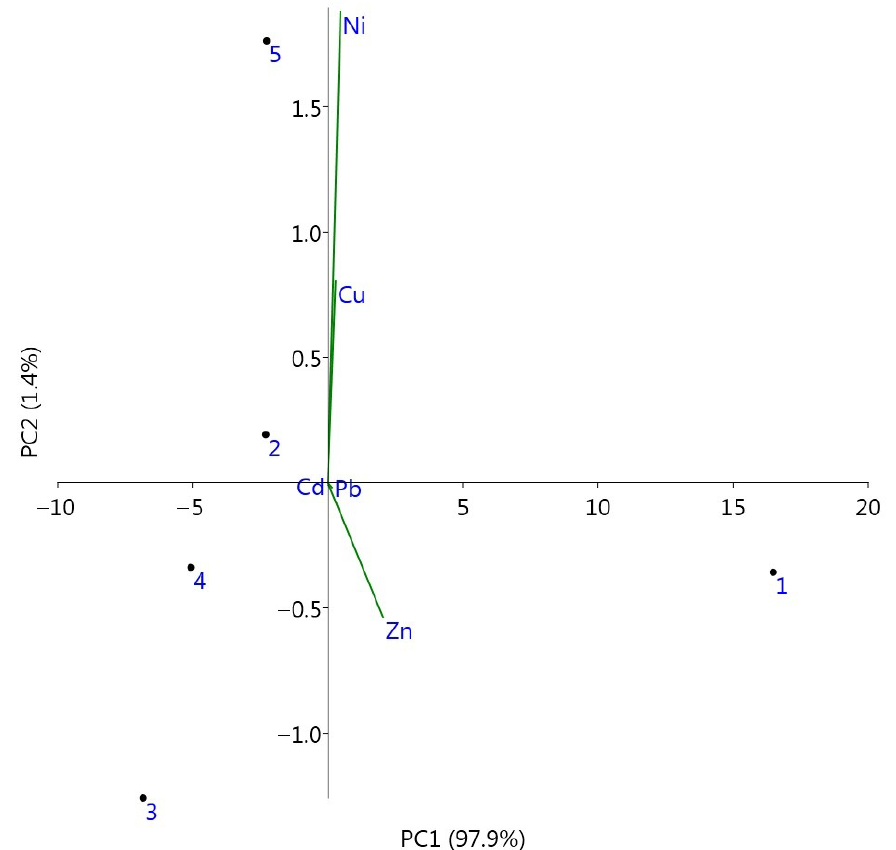
Figure 3. Principal component analysis (PCA) of studied trace metals: 1: Burned soil, Ah, 0–15; 2: Burned soil, Bs, 15–30; 3: Control soil, O/A, 0–13, 4: Control soil, Bs, 13–40; 5: Control soil, B/Ck, 40–55.